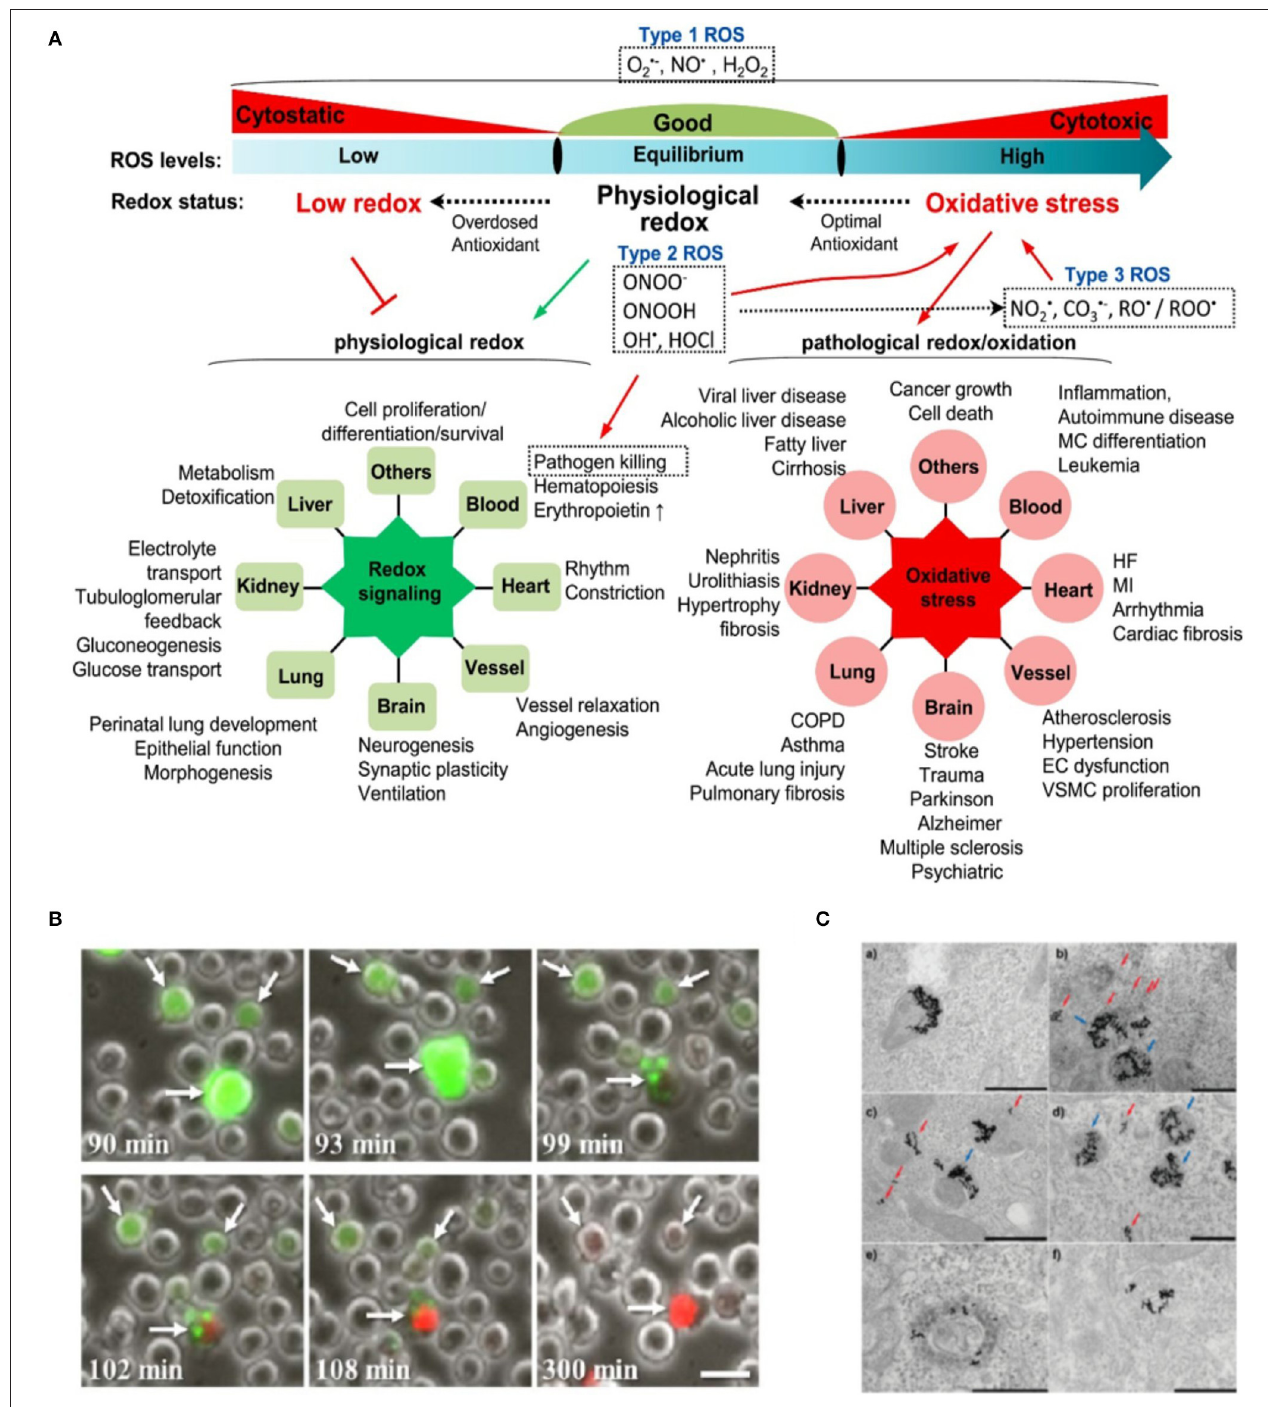
FIGURE 2 | (A) Cellular ROS homeostasis and their pathophysiological effects. Cellular ROS levels undergo consistent changes in redox status. Under physiological condition, ROS are maintained at equilibrium levels to facilitate physiological redox signaling (green radial network on the left). Impaired ROS production causes low redox status and suppresses physiological redox signaling. In the case of high ROS status or oxidative stress, excessive ROS would initiate pathological redox signaling and induce cellular damage and various diseases (red radial network on the right). Type 1 ROS is firstly generated and has essential physiological functions. Type 2 ROS and type 3 ROS are subsequently products of Type 1 ROS and play important role in oxidative stress. Reproduced with permission from Zhang et al. (2019a). (B) Necrosis in Burkitt lymphoma cells following high intracellular levels of ROS in nanoparticle-targeted cells irradiated by eight 550-nm 50-fs pulses. Numbers at the bottom-left of each frame denote the time elapsed from the moment of irradiation. White arrows point to three representative cells in which excessive ROS (green, dihydro-dichloro-fluorescein ROS probe) have accumulated, promoting cell necrosis (red, propidium iodide vital probe). Scale bar represents 20 µ m. Reproduced with permission from Minai et al. (2013). (C) Laser inflicted subcellular damage. TEM micrographs of gold nanoparticles in HeLa cells before (a) and after